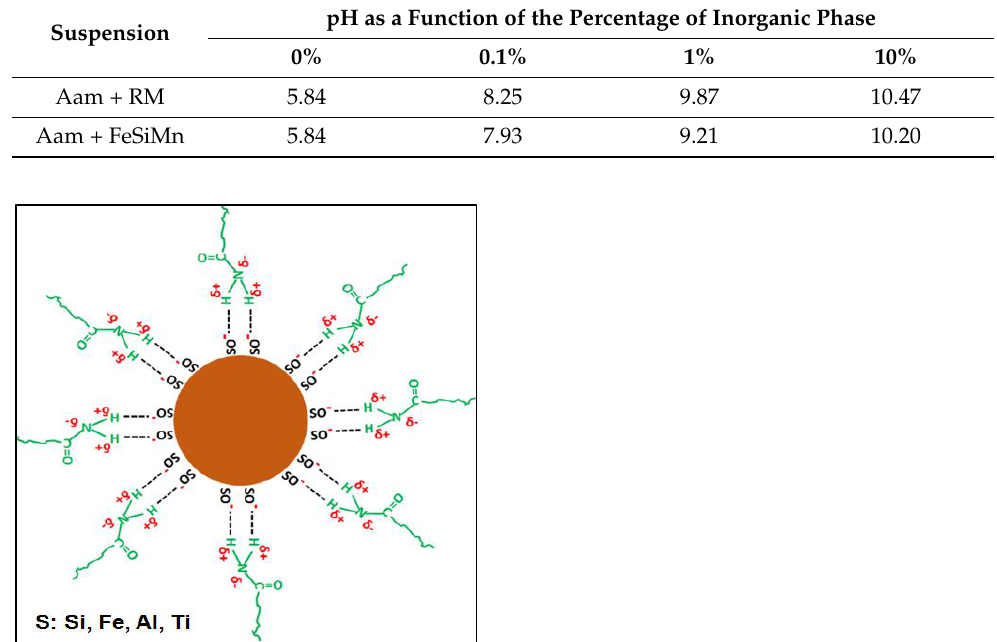
Table 4. pH of the pre-synthesis suspensions used in the synthesis of the hybrid hydrogels.